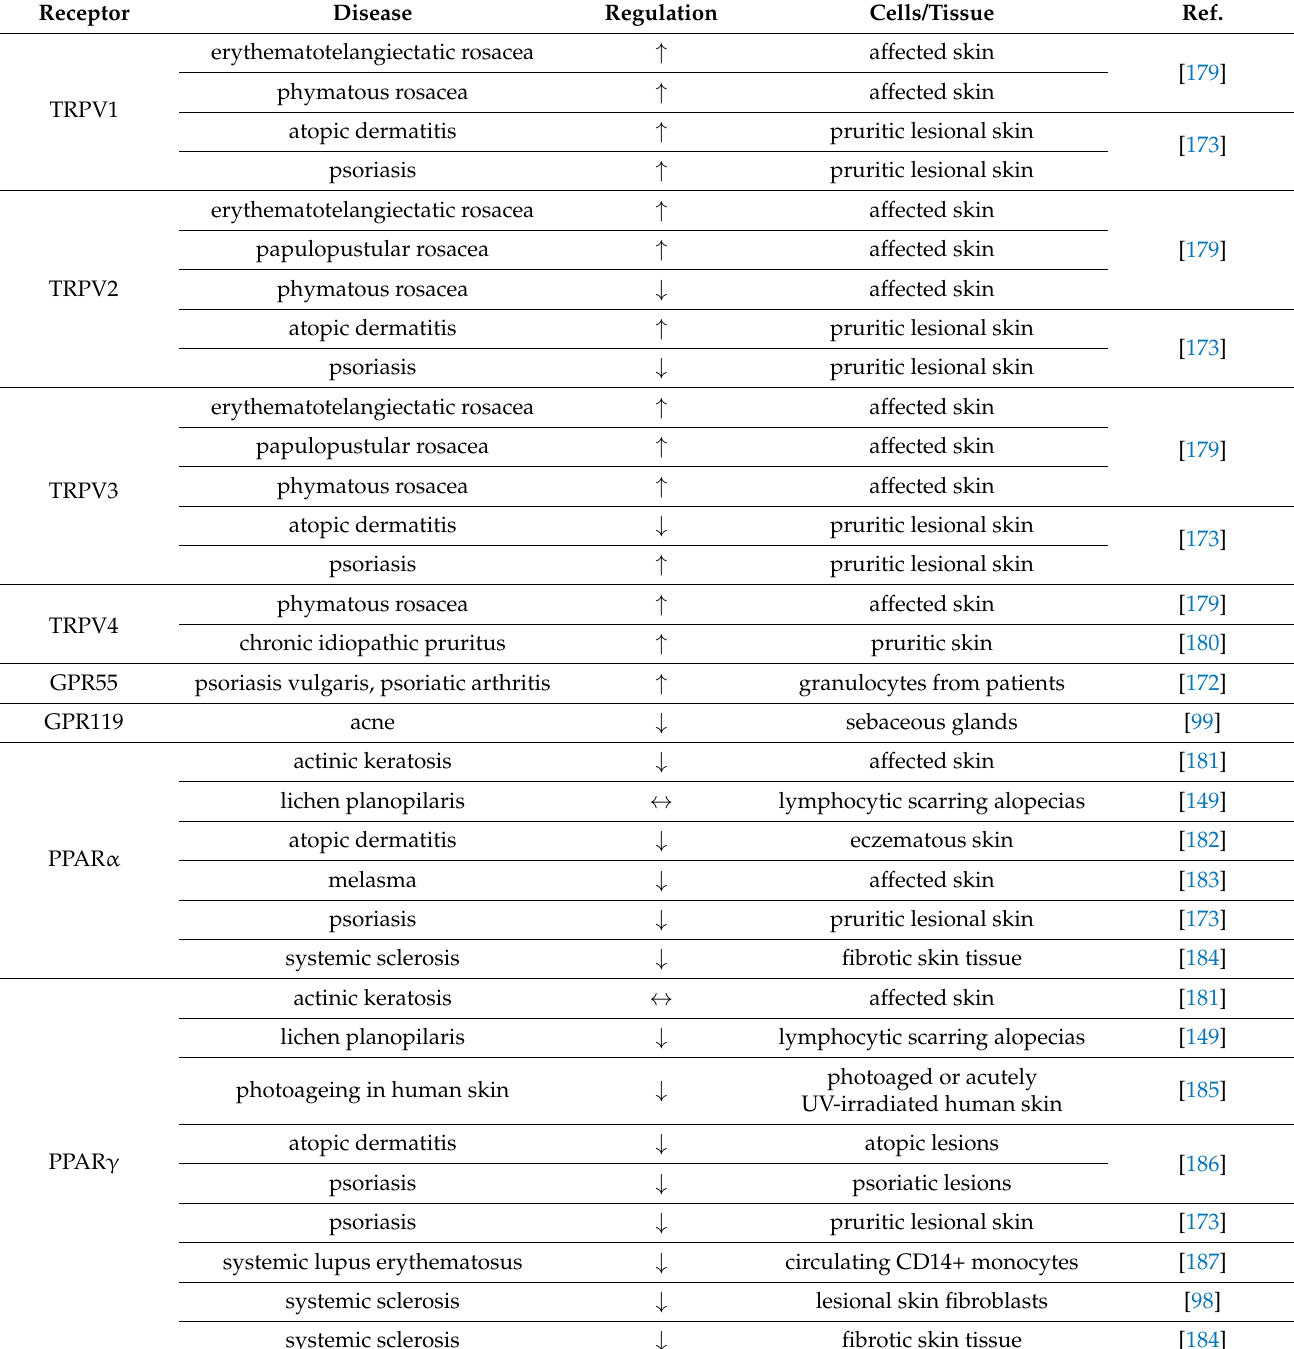
Table 2. Regulation of cannabinoid-modulated receptors in human skin tissue biopsies or plasma.